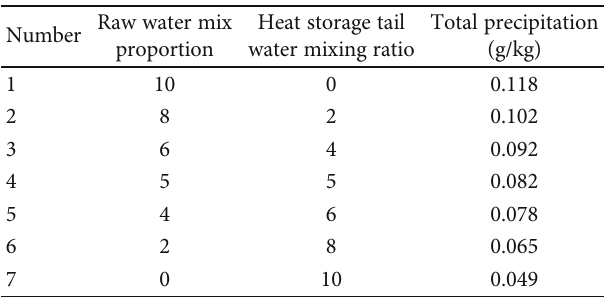
Table 1: Simulation results of total precipitation after mixed simulation of raw water and heat storage tail